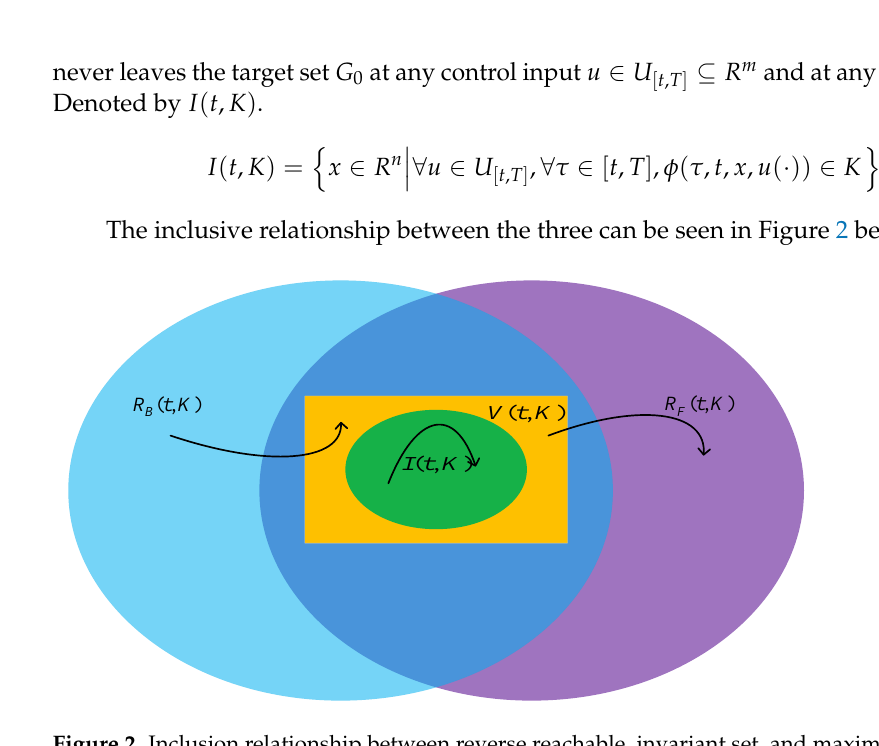
Figure 2. Inclusion relationship between reverse reachable, invariant set, and maximum controllable invariant set [30] .